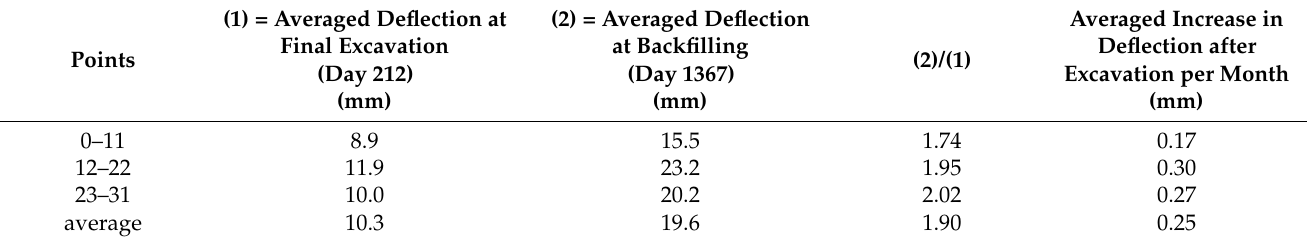
Table 4. Comparison of deflection of top of retaining wall at final excavation and